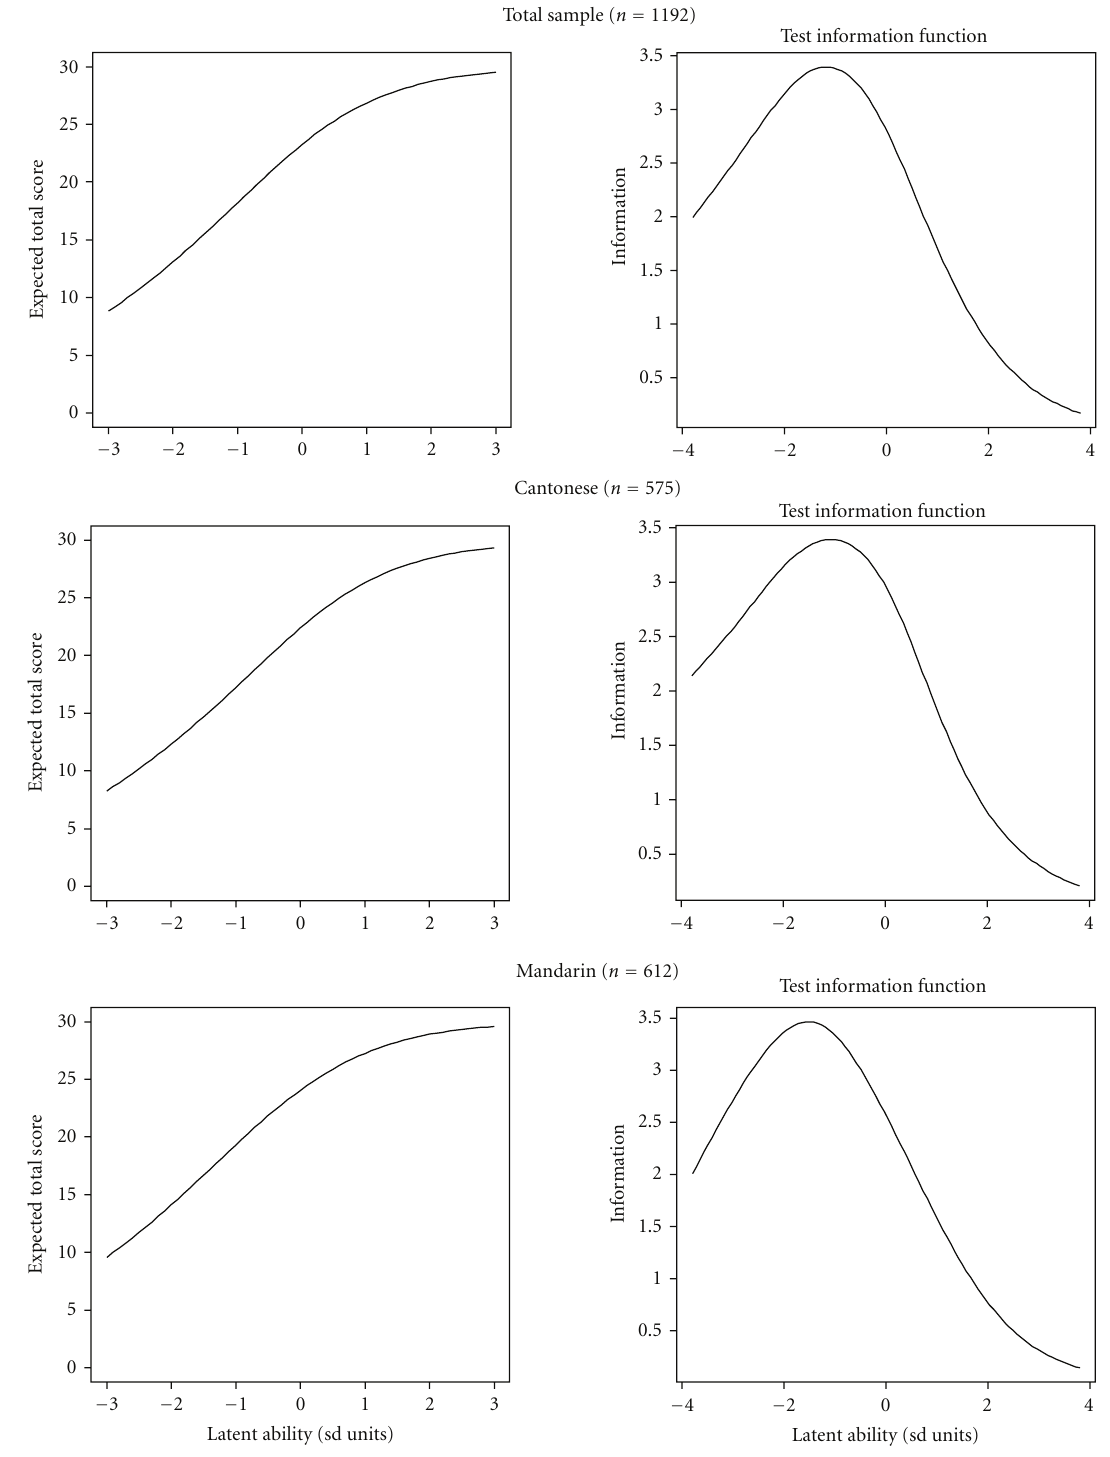
Figure 5: Test characteristic curves and test information curves of the MoCA ChLA total score. The upper figures are for the total sample ( n = 1192); the middle figures are for the Cantonese speakers ( n = 575); the lower figures are for the Mandarin speakers ( n =